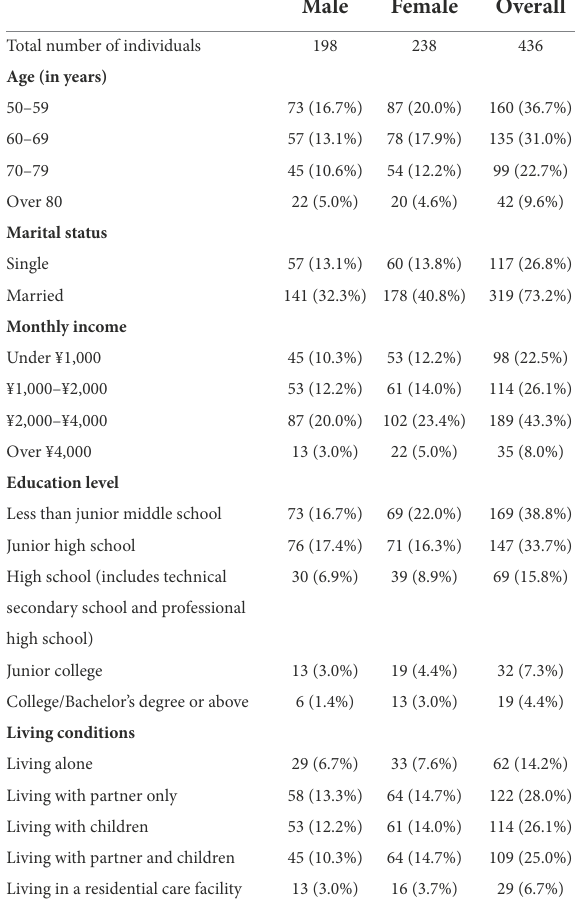
TABLE 1 Participants’ demographic